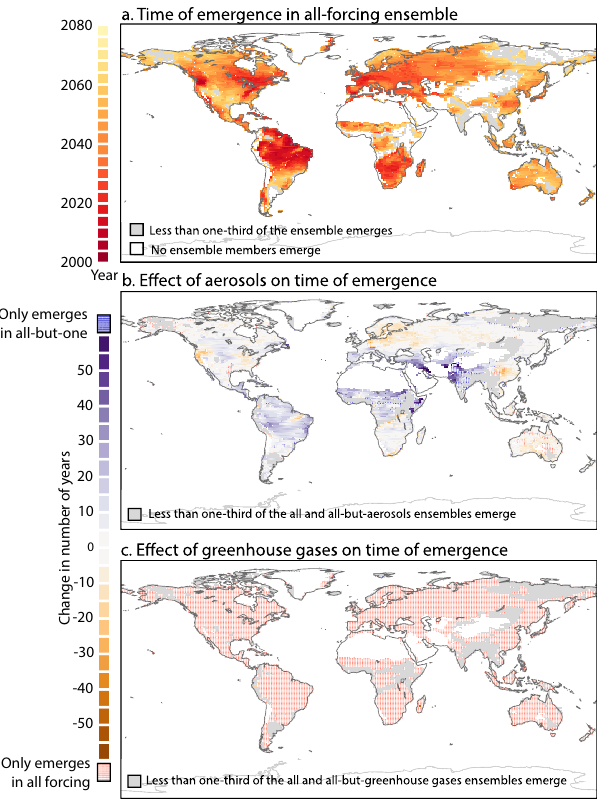
Fig. 4 Anthropogenic impact on the time of emergence (TOE) of extreme fi re weather. a The median TOE of extreme fi re-weather frequency in the ALL forcing ensemble. TOE is the year at which the 10-year moving average of extreme fi re-weather frequency exceeds and permanently remains above the baseline threshold, which is one standard deviation over the mean of the 1980 – 2005 all-forcing (ALL) ensemble. TOE is only shown for grid points with robust TOE, i.e., at least one-third of the ALL ensemble emerges before 2070. Gray areas show TOEs that are not robust, and white shading shows locations where none of the ensemble members emerge before 2070. b Median TOE difference between the ALL and the all-but-aerosol (XAER) ensemble. Negative (positive) values indicate an acceleration (delay) in the TOE. Blue stippling shows robust TOE for the XAER ensemble, but not for the ALL ensemble. Coral stippling shows robust TOE for the ALL ensemble, but not for the XAER ensemble. Gray areas have no robust TOE in both the ALL and XAER ensembles, c , b but for greenhouse gases (XGHG). Oceans, glaciers, and bare land are masked in white in all